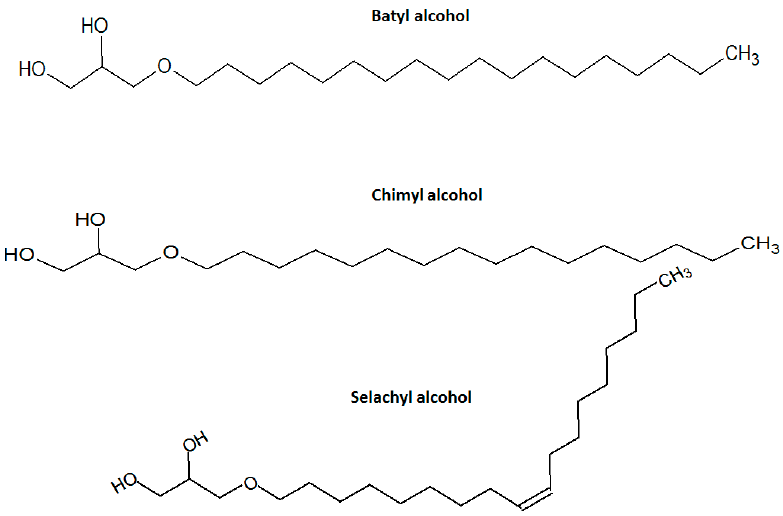
Figure 1. Chemical structures of alkylglycerol derivatives.